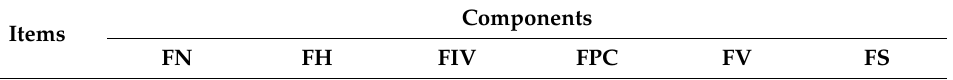
Table 4. Factorial loads by the principal components extraction method and Varimax rotation with Kaiser normalization.